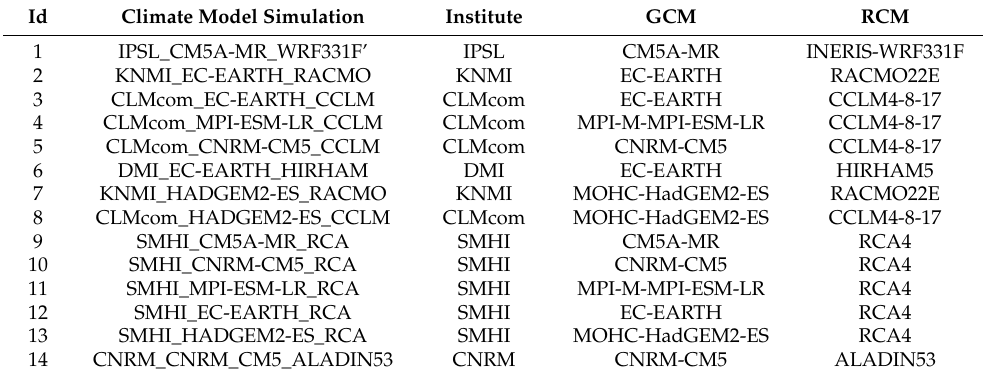
Table 1. List of Euro-CORDEX simulations considered in this study. The names of simulations identify the research institute, the global circulation model, and the regional climate model. Id Climate Model